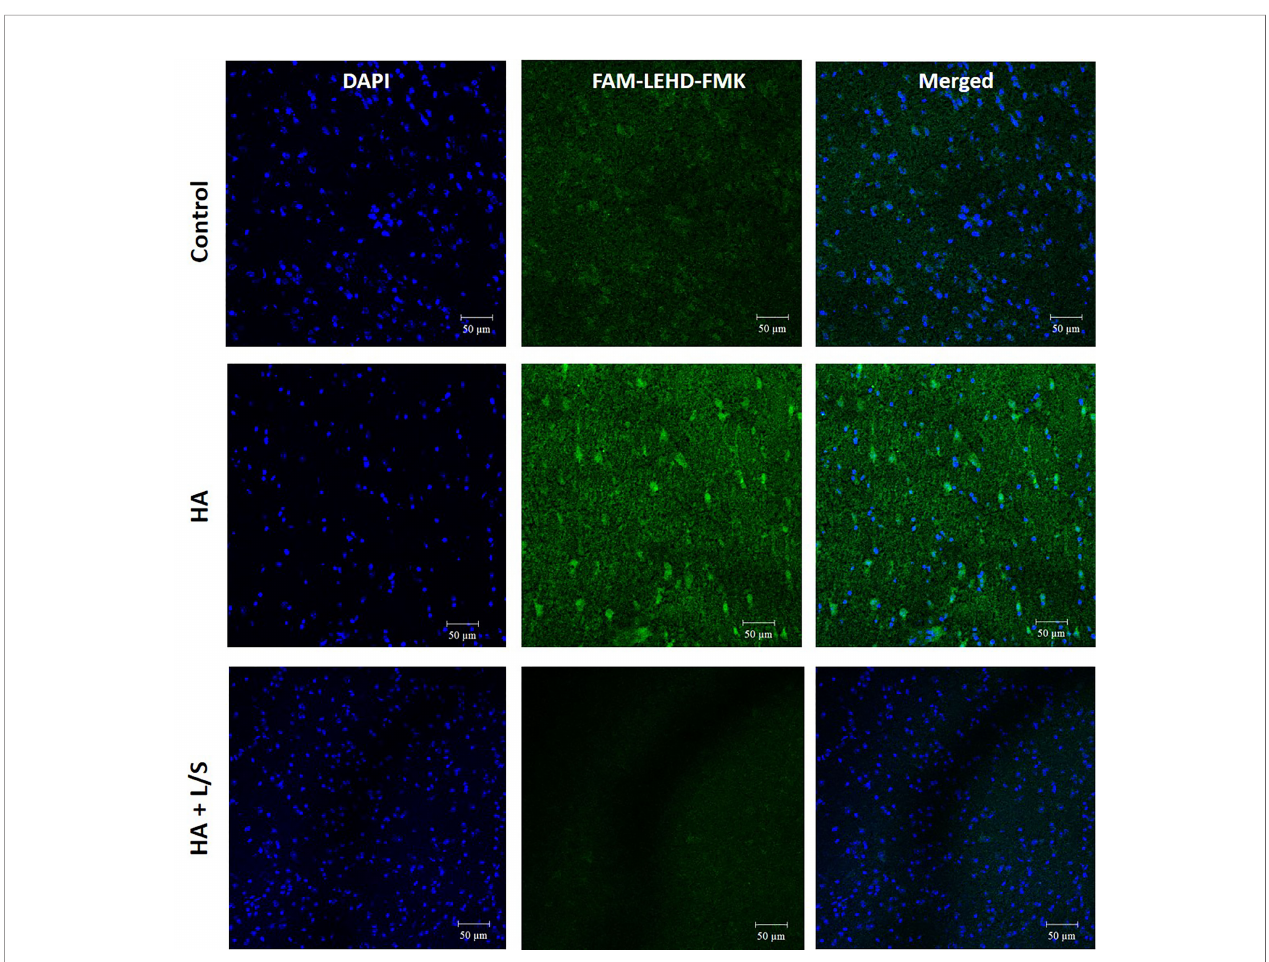
FIGURE 5 | The neuroprotective effect of the symbiotic pair of L. reuteri JBD400 and S. rubneri in hyperammonemia. The symbiotic pair of L. reuteri JBD400 and S. rubneri JBD420, 10 9 CFU each in the total volume of 200 m L PBS, was daily administered into each C57BL/6 mice (n = 3 per group) for 40 days. After inducing Hyperammonemia by injection of TAA at the dose of 250 mg/kg body weight into the mice, histochemical analysis by using the fl uorescent inhibitor probe FAM- LEHD-FMK on the brains was performed. HA represents the hyperammonemic mice. HA+L/S represents the hyperammonemic mice fed the symbiotic pair. DAPI represents DAPI staining for nucleus detection and FAM-LEHD-FMK represents the histochemical reaction to detect caspase 9 activation by the fl uorescence dye. Magni fi cations were × 200. Bar =50 µm.